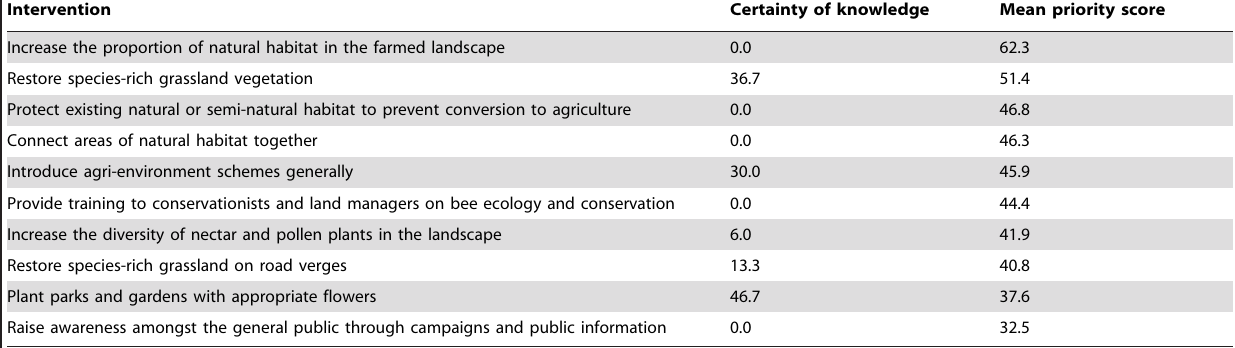
Table 1. Research priorities